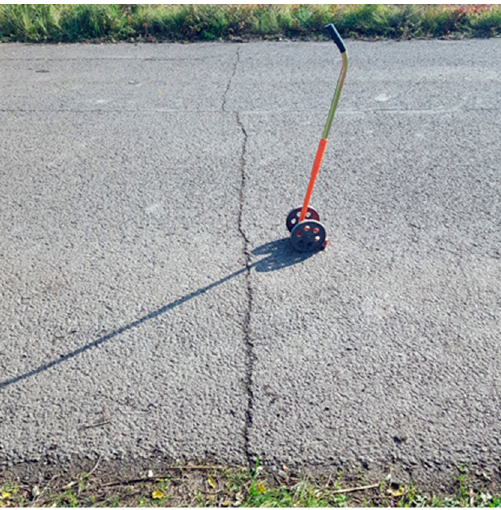
Figure 14. Recording road defects by visual inspection.